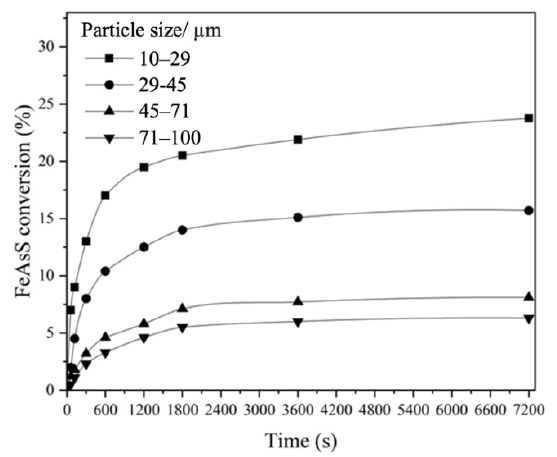
Figure 7. Effect of FeAsS particle size on its hydrothermal conversion (100 rpm; 503 K; 0.1 mol/L of H 2 SO 4 ; 0.16 mol/L of Cu).